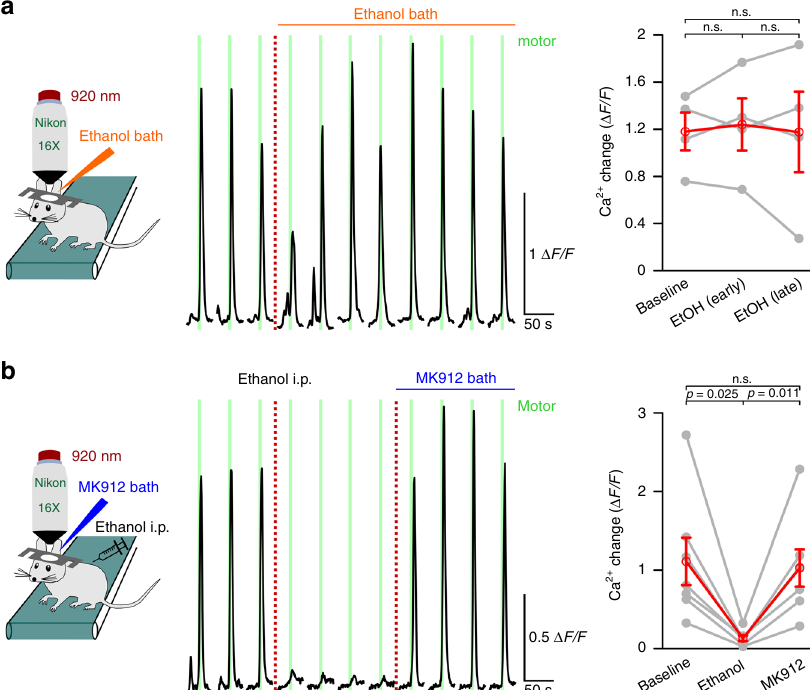
Fig. 9 Ethanol inhibits the noradrenergic system at noradrenergic neuron somata or dendritic input but not at the terminals. a Left, scheme of the awake topical pharmacology experimental design. Middle, representative average Ca 2 + response trace of BG processes of Aldh1l1-CreER T2 ;Ai95 mouse. Ethanol bath concentration was 30 mM. Green bars, enforced locomotion. Right, Population data, mean Δ F / F 10s ± SEM of trials 1 – 3, 5 – 7, and 9 – 11, respectively. n = 4 mice; repeated measures ANOVA ( F (2, 6) = 0.114) was followed by Tukey – Kramer correction. b as a ; however, ethanol was injected (2 g/kg i.p.) and MK912 bath concentration was 15 μ M. Population data, mean Δ F / F 10s ± SEM of trials 1 – 3, 5 – 7, and 9 – 11, respectively. n = 7 mice;